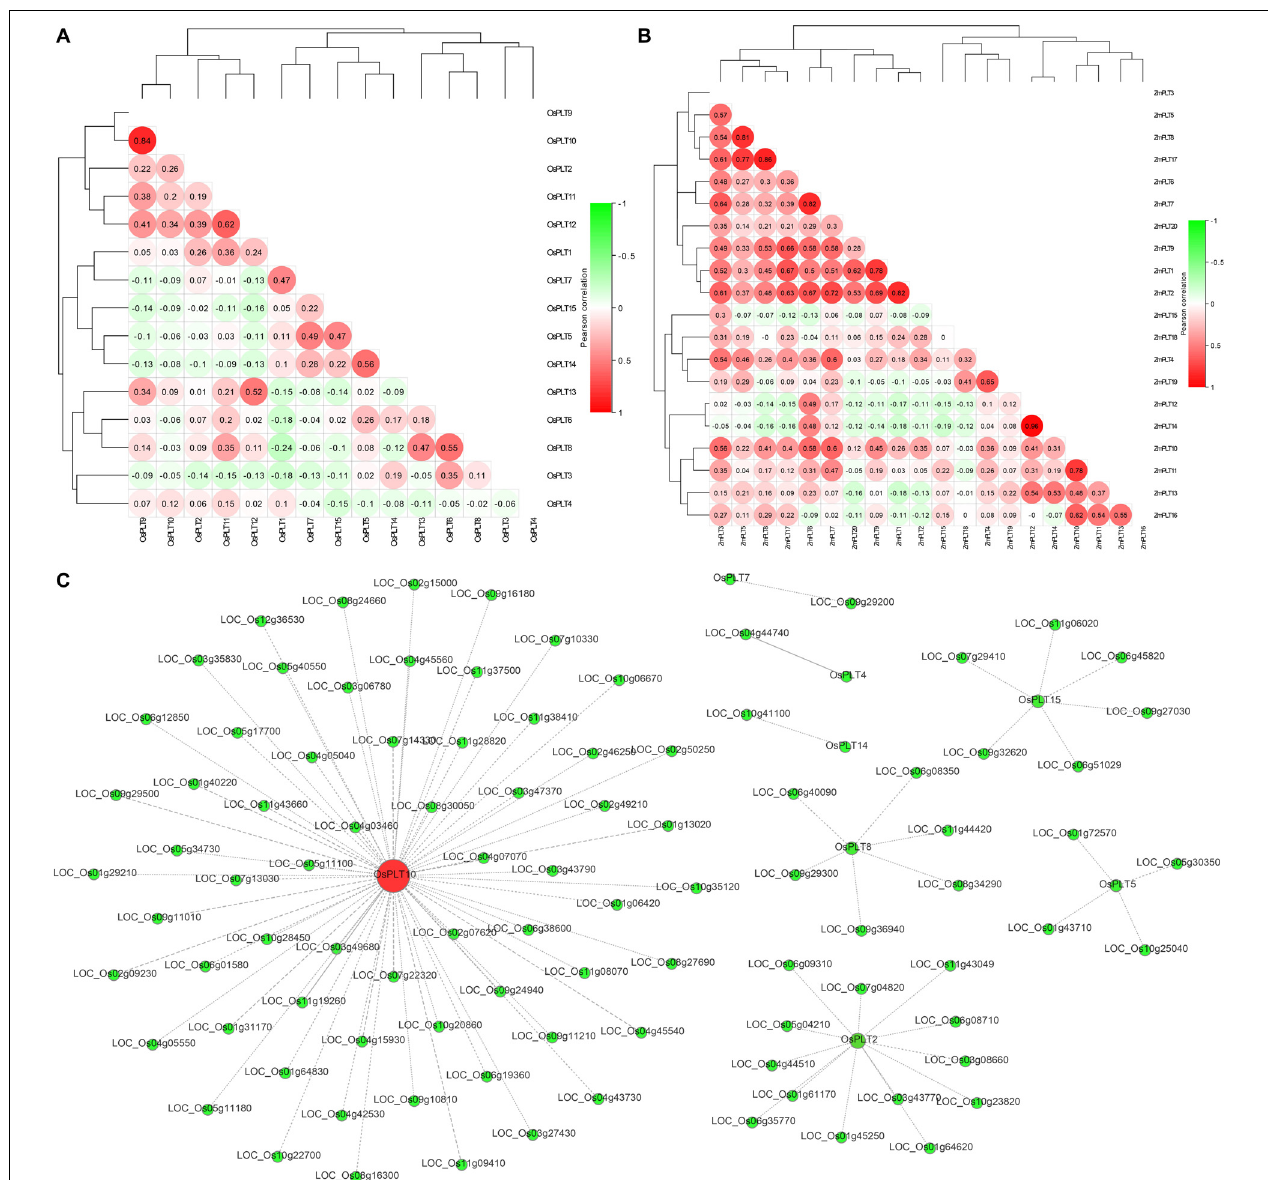
FIGURE 8 | Pearson’s correlation coefficient among PLT genes in rice (A) and maize (B) , respectively. A co-expression network using rice PLT genes as query genes was constructed in the Rice Expression Database (http://expression.ic4r.org/) with Pearson’s r -value > 0.85 (C) .